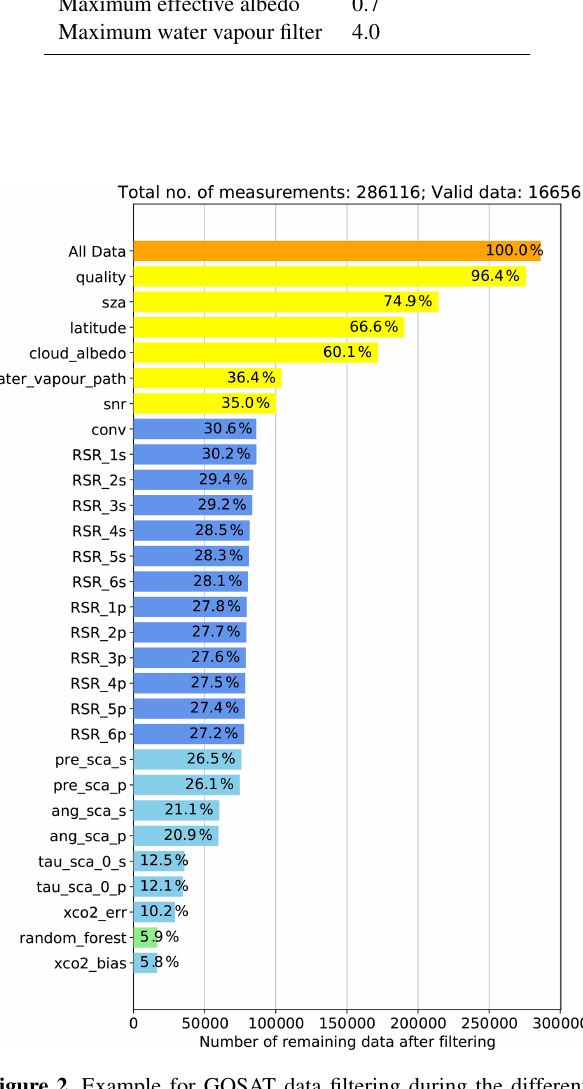
Figure 2. Example for GOSAT data filtering during the different processing steps (April 2019). Filters are listed in sequential order from top to bottom on the vertical axis. Numbers in the horizontal bars denote the percentage of remaining data after this filter was ap- plied. Orange: total number of measurements before filtering. Yel- low: pre-processing filters. Blue: step 1 post-processing filters (con- vergence and noise). Green: random forest post-processing filter. Light blue: additional post-processing